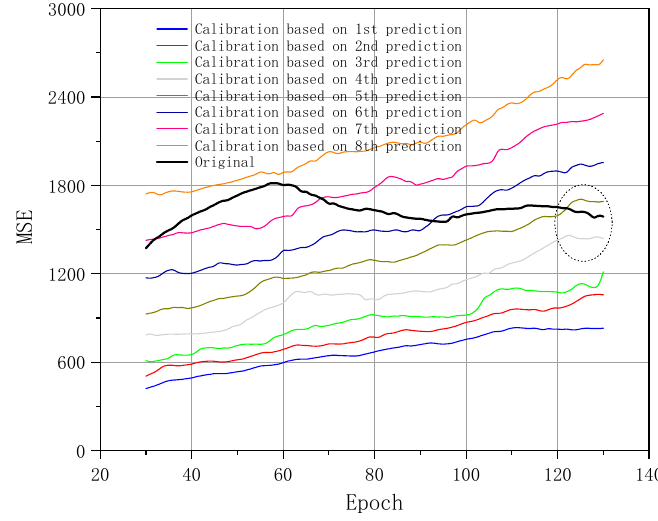
Figure 8. MSE results regarding FEA computation after calibration.